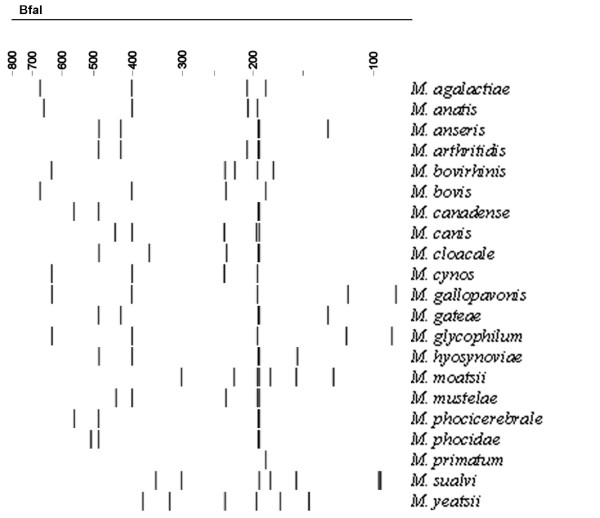
Calculated ARDRA profiles of Mycoplasma spp. that can be differentiated using BfaI, but had undistinguishable AluI restriction profiles.